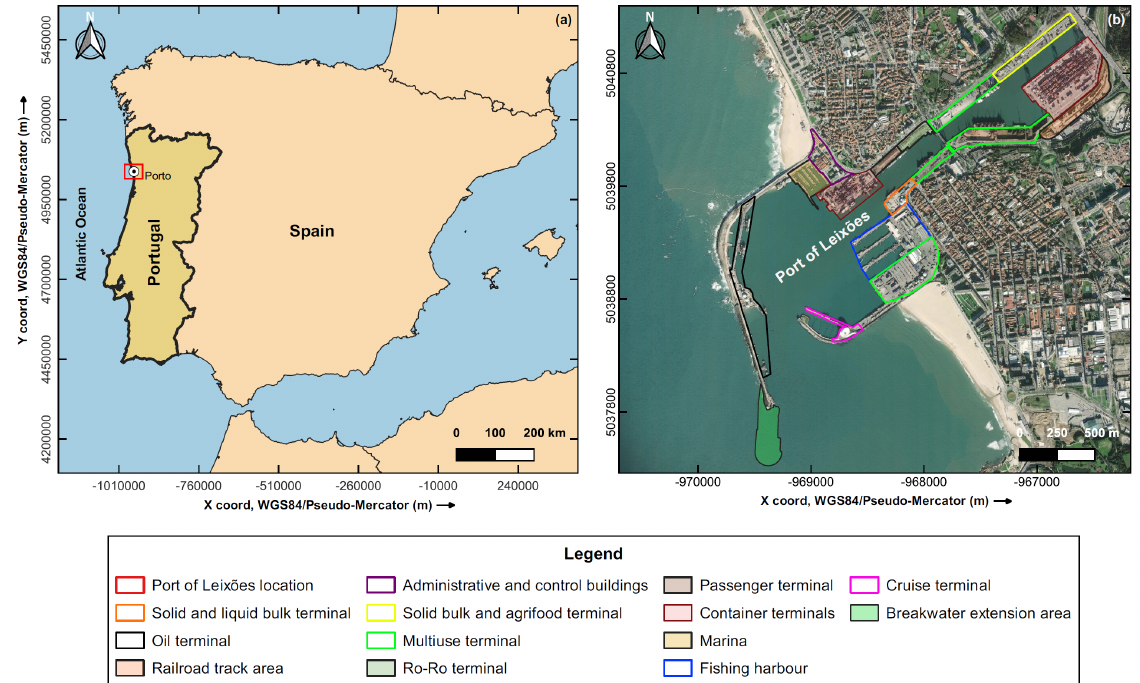
Figure 1. Location ( a ) and main terminals ( b ) of Port of